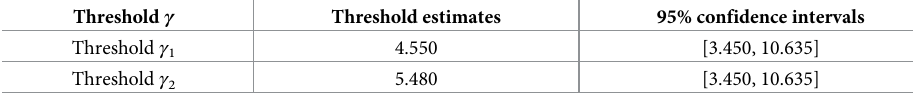
Table 7. Threshold estimates and confidence intervals.